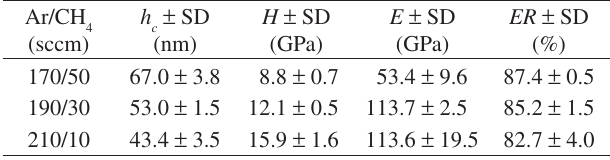
Figure 2. Concentrations of C, Ti and O estimated from Auger spectroscopy for Ti-doped carbon coatings deposited with different Ar and CH total mass flow is 220 sccm. Lines are guides to the eyes.